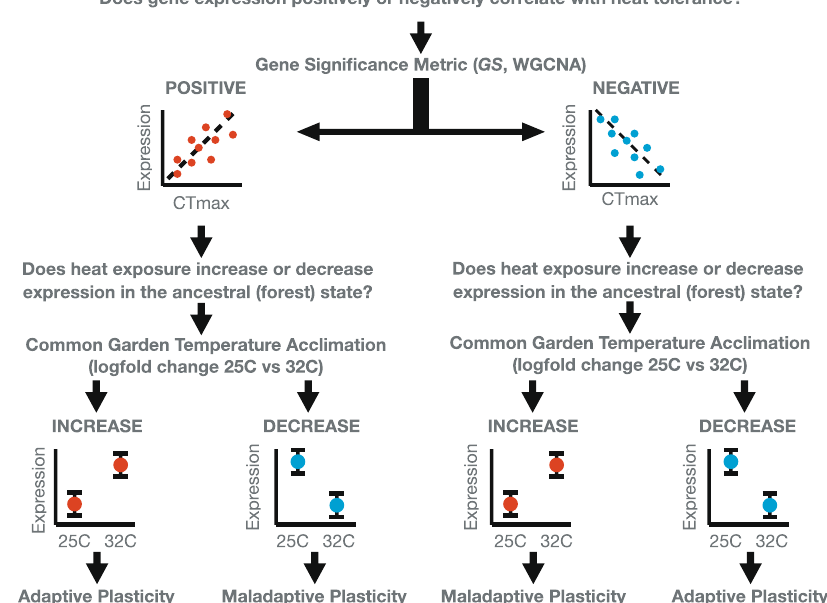
Fig. 5 Theoretical work fl ow for categorizing the ancestral plastic response of a given gene to increased urban temperatures as adaptive or maladaptive. First, the direction of gene expression correlation (measured from a panel of 130 lizards) was used to identify a given gene as a positive regulator (positively correlated with heat tolerance, CT MAX ) or a negative regulator (negatively correlated with CT MAX ). Next, the gene was categorized as upregulated (increasing in expression) or downregulated (decreasing in expression) in forest lineages born and raised in common conditions (a proxy for the ancestral condition) in response to increased temperature (25 °C – 32 °C). Theoretical dots and bars represent mean ± 1 SE. Positive regulators displaying increased expression at high temperature and negative regulators displaying decreased expression at high temperature in common garden lizards were categorized as displaying adaptive plasticity. Decreased expression of positive regulators at high temperature and increased expression of negative regulators at high temperature in common garden individuals were deemed maladaptive plasticity.